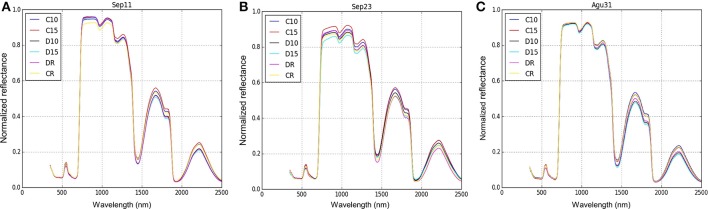
Spectral signature profile of two genotypes (Perla Negra—C and Diacol Capiro—D) under three drought levels. The spectral data were collected in three different periods: before drought (A), 9 days of suffering from drought (B) and after drought—rehydration (C).